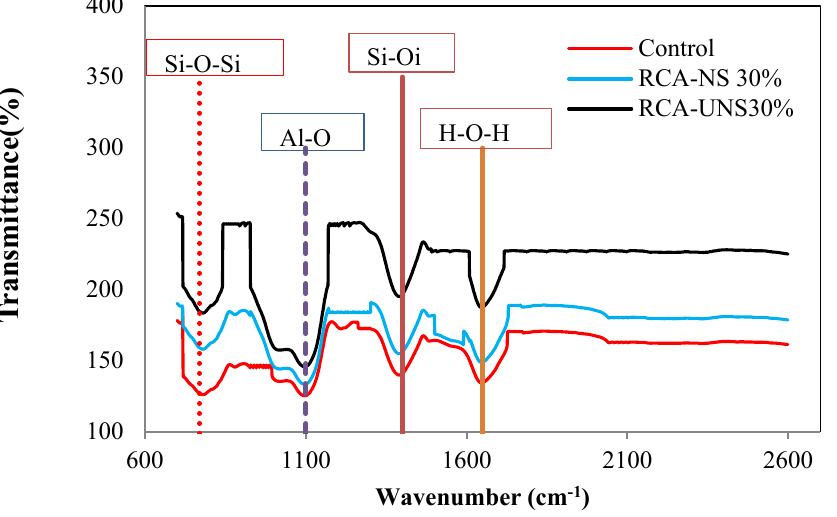
Figure 12. Fourier transform infrared (FT-IR) spectra of the control, RCA-NS 30%, and RCA-UNS 30% samples at 28 days.